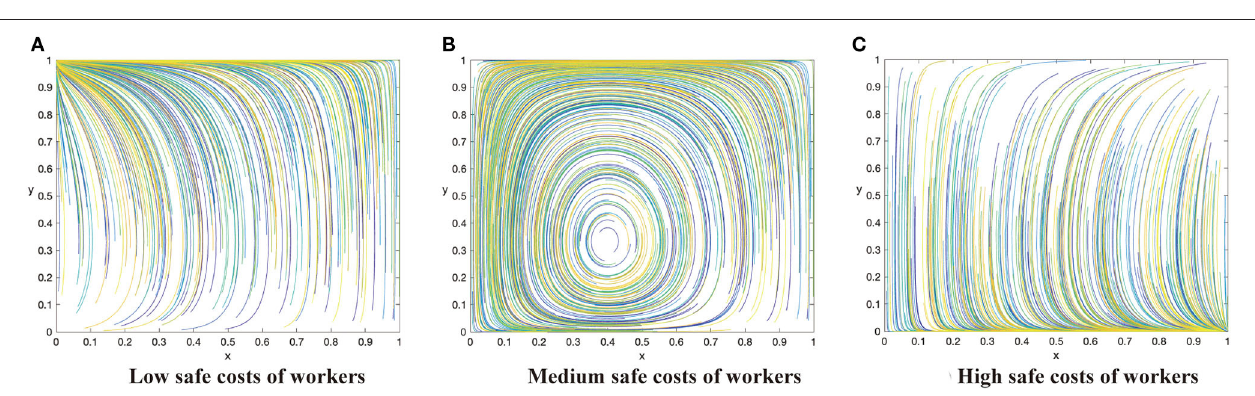
FIGURE 4 | The dynamic evolutionary path of the game in sub-category 3-2, including low safety costs to workers (A) , high safety costs to workers (C) , and medium safety costs to workers (B) .